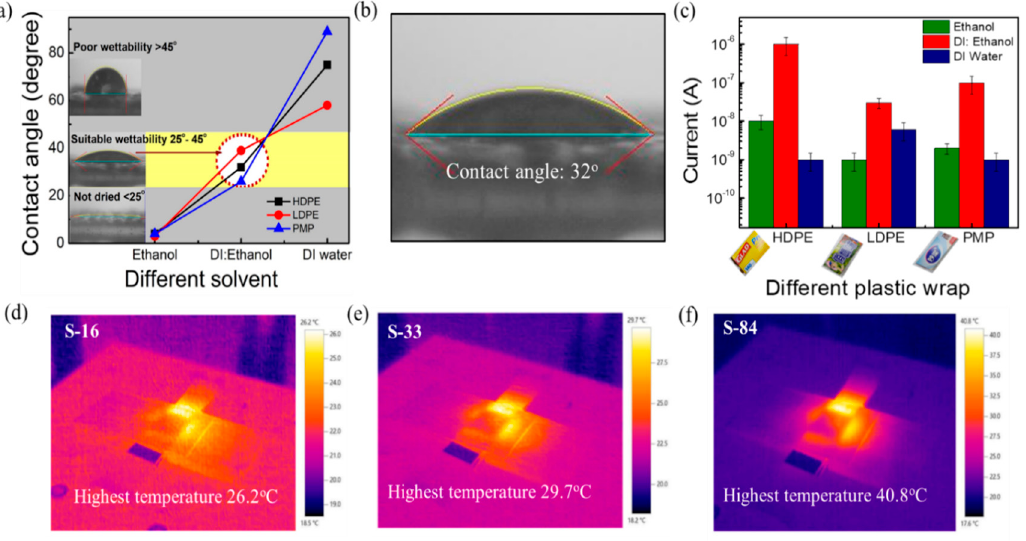
Figure 2. Selection of plastic wrap and solvent. ( a ) Measurement of contact angle for wettability test on different plastic wraps (HDPE/resin, LDPE, and PMP) using different solvents (ethanol, DI water: ethanol, and DI water). ( b ) Image of contact angle using DI water: Ethanol (1:1) solution on HDPE/resin plastic wrap. ( c ) Current of the film of different plastic wraps using different solutions. Thermal images of ( d ) S − 16, ( e ) S − 33, and ( f ) S − 84 .